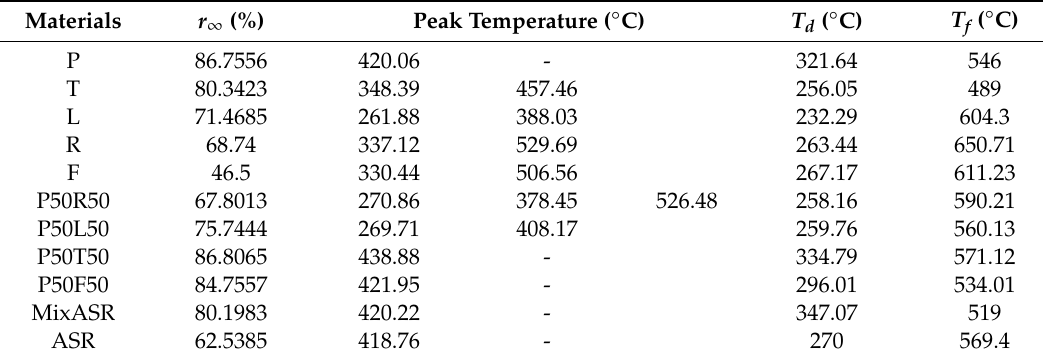
Figure 2. The thermogravimetric (TG), derivative thermogravimetry analysis (DTG), and conversion thermograms of automobile shredder residue (ASR) and its main components. ( a ) TG thermograms reflect the change in mass percentage during pyrolysis process. ( b ) DTG thermograms refers to the Table 3. The results of the weight loss rate and characteristics of the reaction temperature. Here, P, T, L, R, and F represent plastics, textiles, leather, rubber, and foam, respectively.